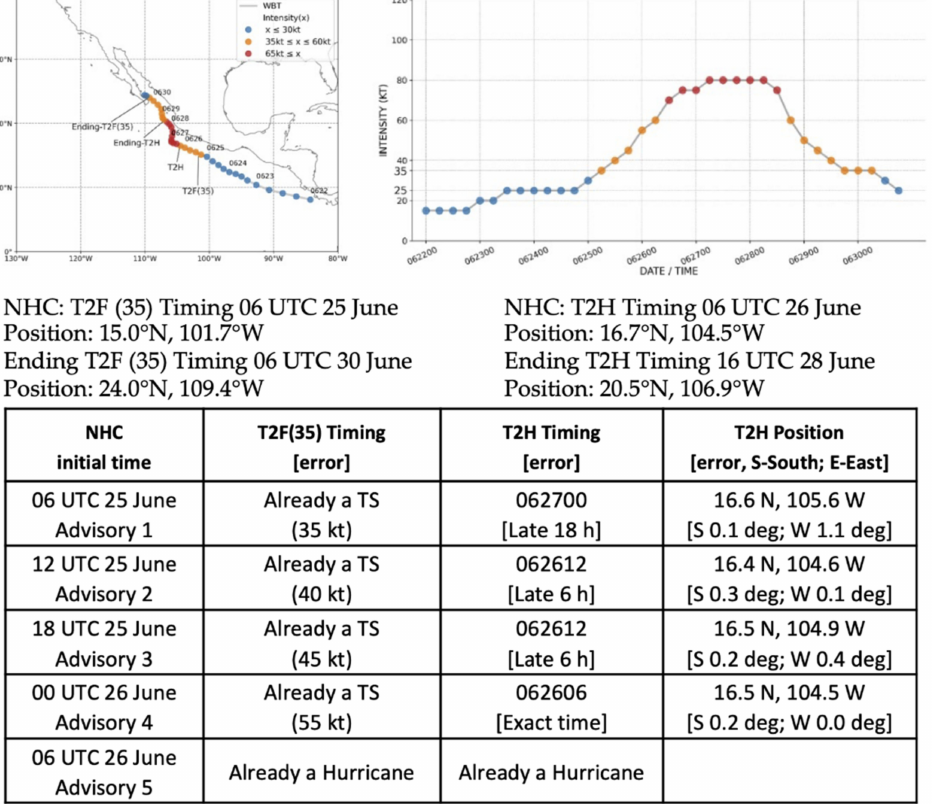
Figure 4. Hurricane Linda track and intensity plots with a validation summary table similar to Figure 1 except for the ECEPS pre-Linda forecasts and here in the original format of Elsberry et al. [1] to illustrate the information that is objectively derived from each forecast to assist the forecaster in evaluating and summarizing in time the